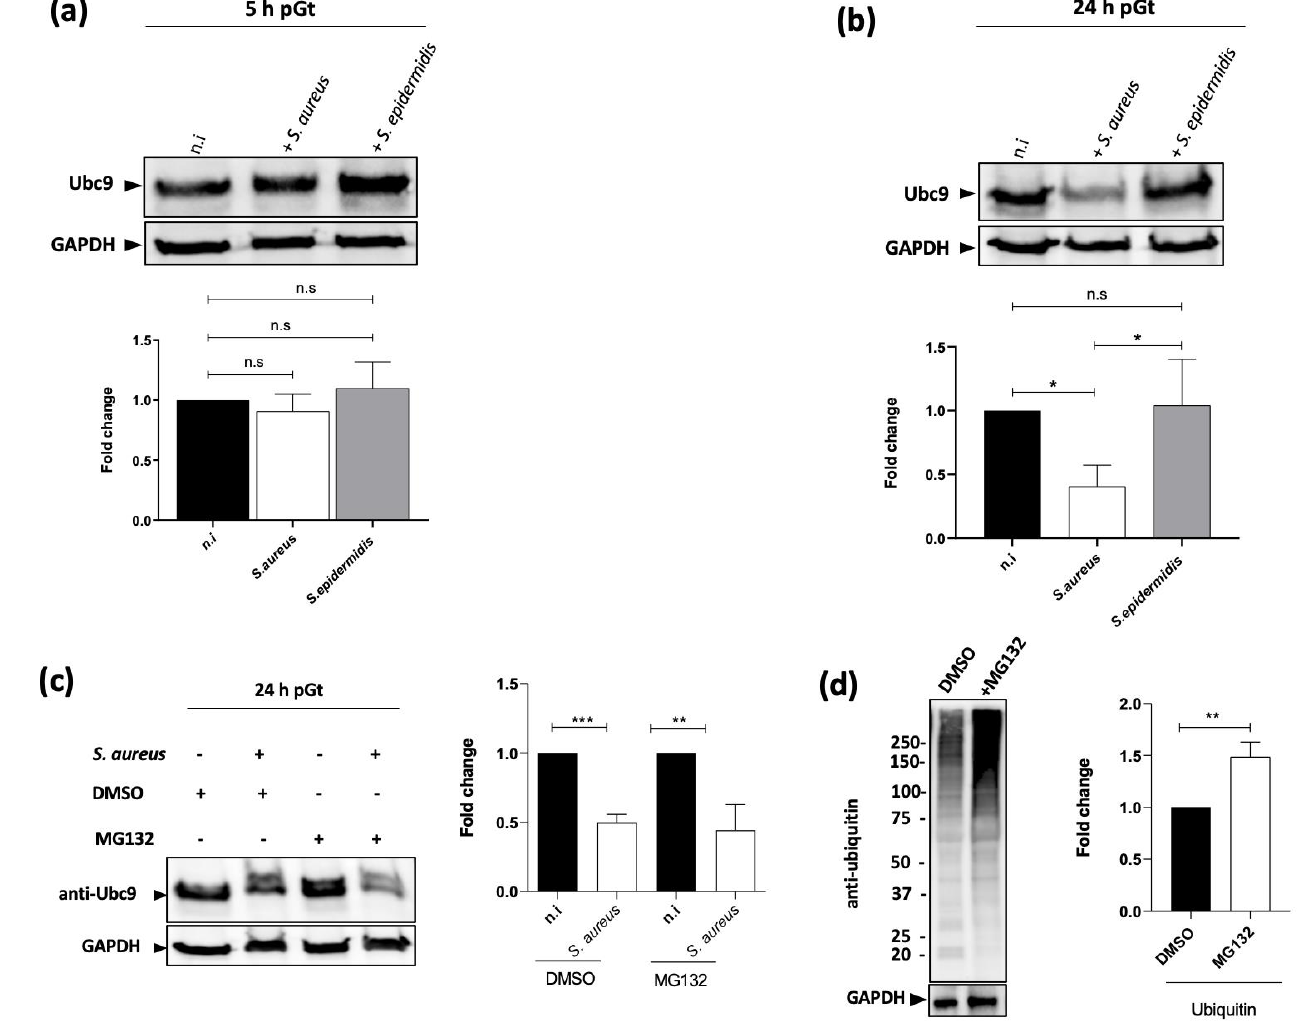
Figure 5. S. aureus decreases the Ubc9 protein level in a proteasome-independent pathway. Immunoblot analysis of Ubc9 and GAPDH levels in lysates of macrophages infected with S. aureus and S. epidermidis for 5 h ( a ) and 24 h ( b ) post-gentamicin treatment. n.i., non-infected control cells. h, hour post-gentamicin treatment. Ubc9 bands were quantified from three independent experiments and normalized to GAPDH levels. The graph represents fold change compared to non-infected cells at 5 h and 24 h post-gentamicin. n.s.: non-significant; * p ≤ 0.05 by one-way ANOVA with Bonferroni’s multiple-comparison test. ( c , d ) Immunoblot analysis of Ubc9 ( c ), ubiquitin-conjugated proteins ( d ) in macrophages pretreated or not with MG132 for 3 h prior to infection with S. aureus . Bands were quantified from three independent experiments using Image lab software (ChemiDoc) and normalized to GAPDH. The fold change graph represents the percentage of Ubc9 and ubiqutiin-conjugated proteins obtained in the infected cells compared to the quantity of proteins in the cells treated with DMSO (right panels). *** p ≤ 0.001; ** p ≤ 0.01; * p ≤ 0.05 by one-way ANOVA with Bonferroni’s multiple-comparison test.